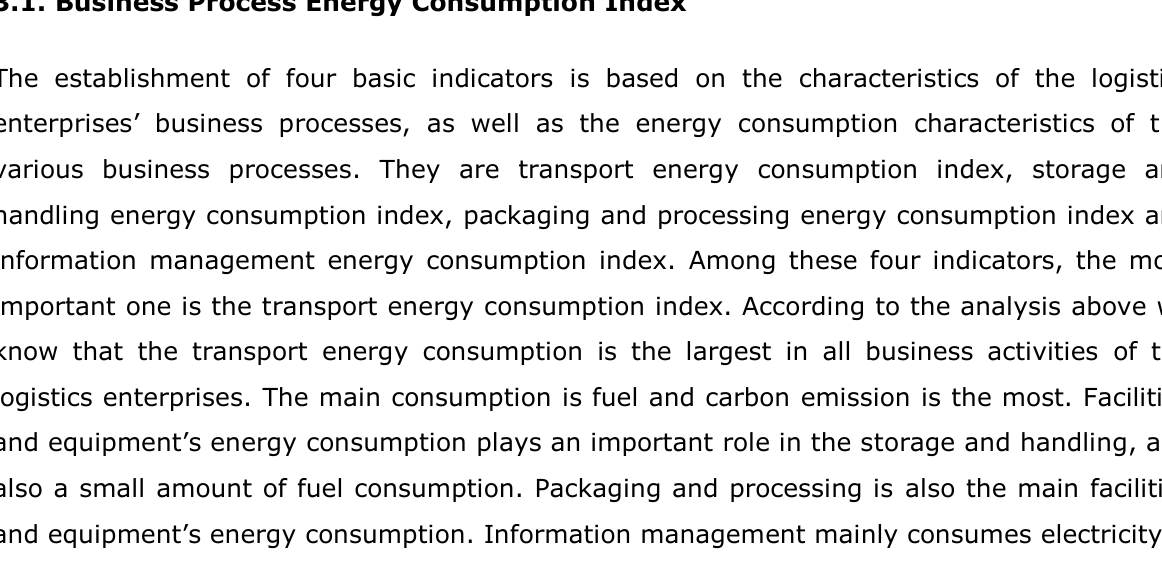
Figure 2. Low-carbon impact factors Index system of logistics